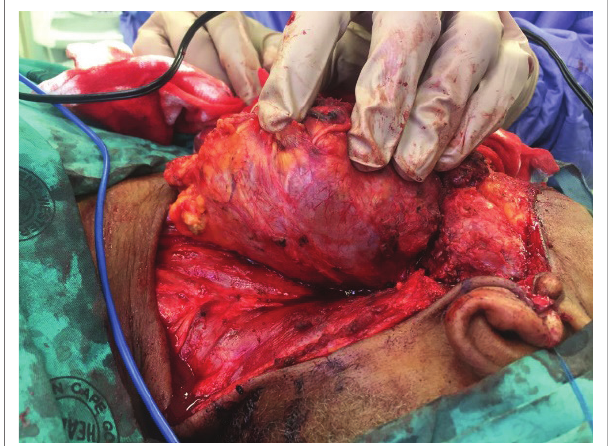
FIGURE 3 : Intra-operative image of the left cervical nodal-mass conglomerate. It was dissected off the left common carotid artery, with ligation of the left internal jugular vein.